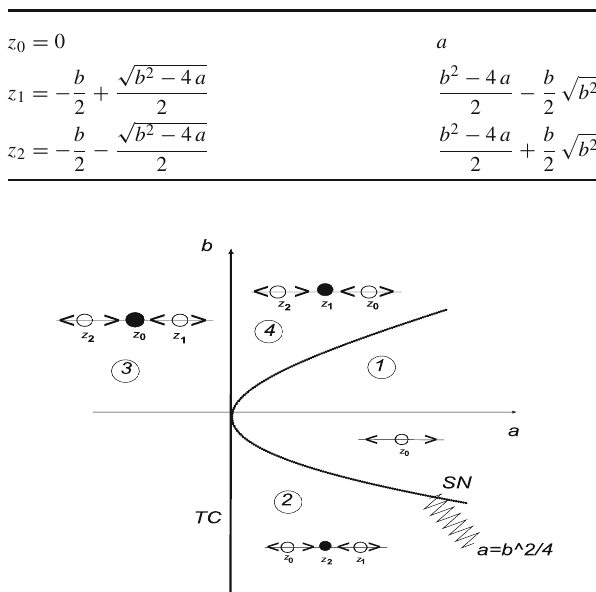
Fig. 21 Bifurcation diagrams and schematic portrait where we have four topologicallydifferentareasthatareseparatedbysaddlenode (SN) and transcritical (TC) bifurcations. The solid dots and the circle dots in each phase portraits represent stable fixed points (sinks) and unstable fixed points (sources) respectively. The thick lines represents lines of bifurcation such as b -axis for TC and the parabola, a = b 2 / 4, for SN. The thin line just represents jus an axis 1 + ω . The flow behavior as depicted in Fig. 20B reveals 6 α